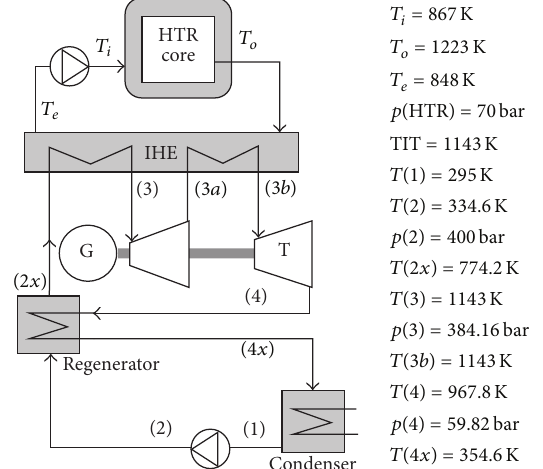
Figure 3: Diagram of the RC-based power plant operating with carbon dioxide, powered by a helium-cooled